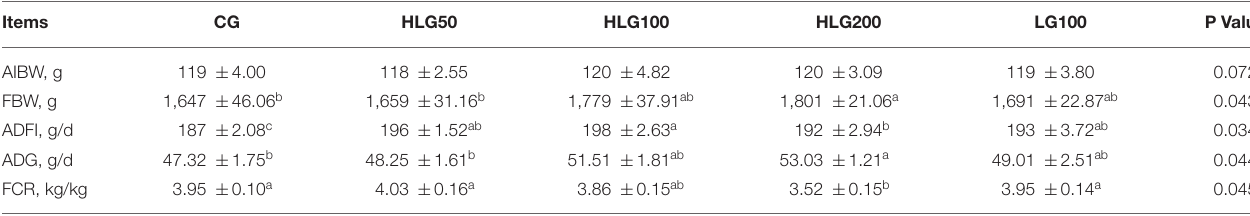
TABLE 5 | Effects of hydroxylated lecithin on growth performance of Jiangnan White goslings. Items